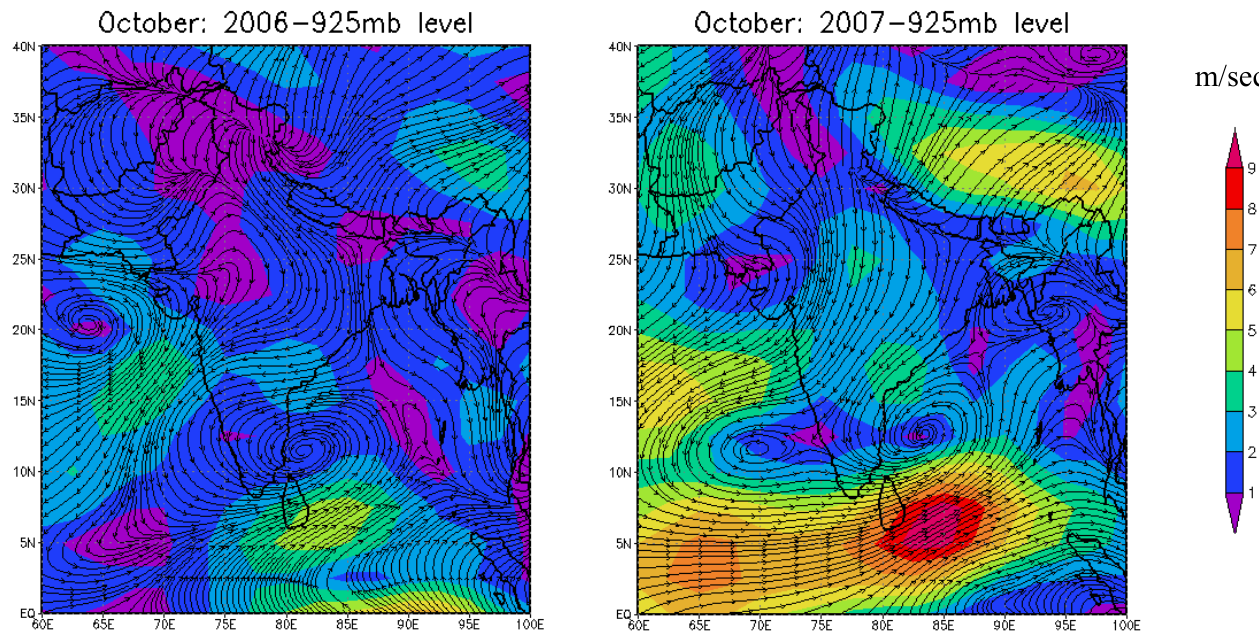
Fig. 1. Synoptic wind patterns at 925hPa level over Indian region for the period of October 2006 and